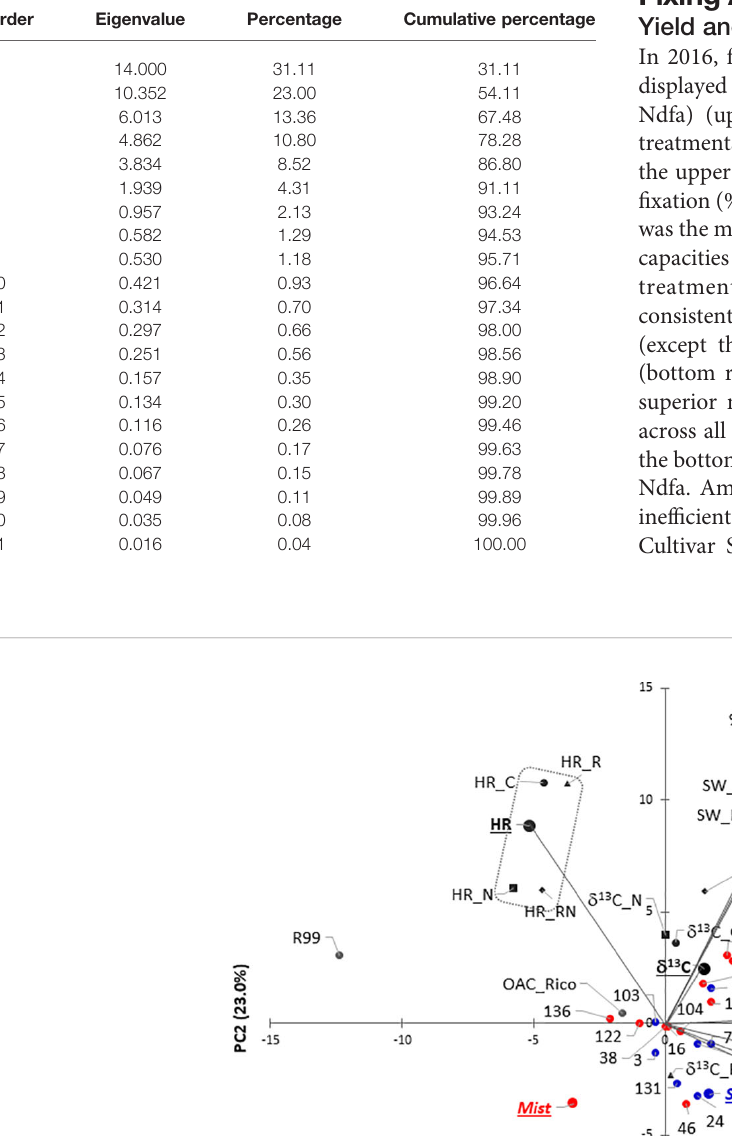
TABLE 9 | | Eigenvalues of the correlation matrix from the principal component analysis of the nine traits evaluated in 22 common bean genotypes at the Elora research station, ON in 2017 and 2018.